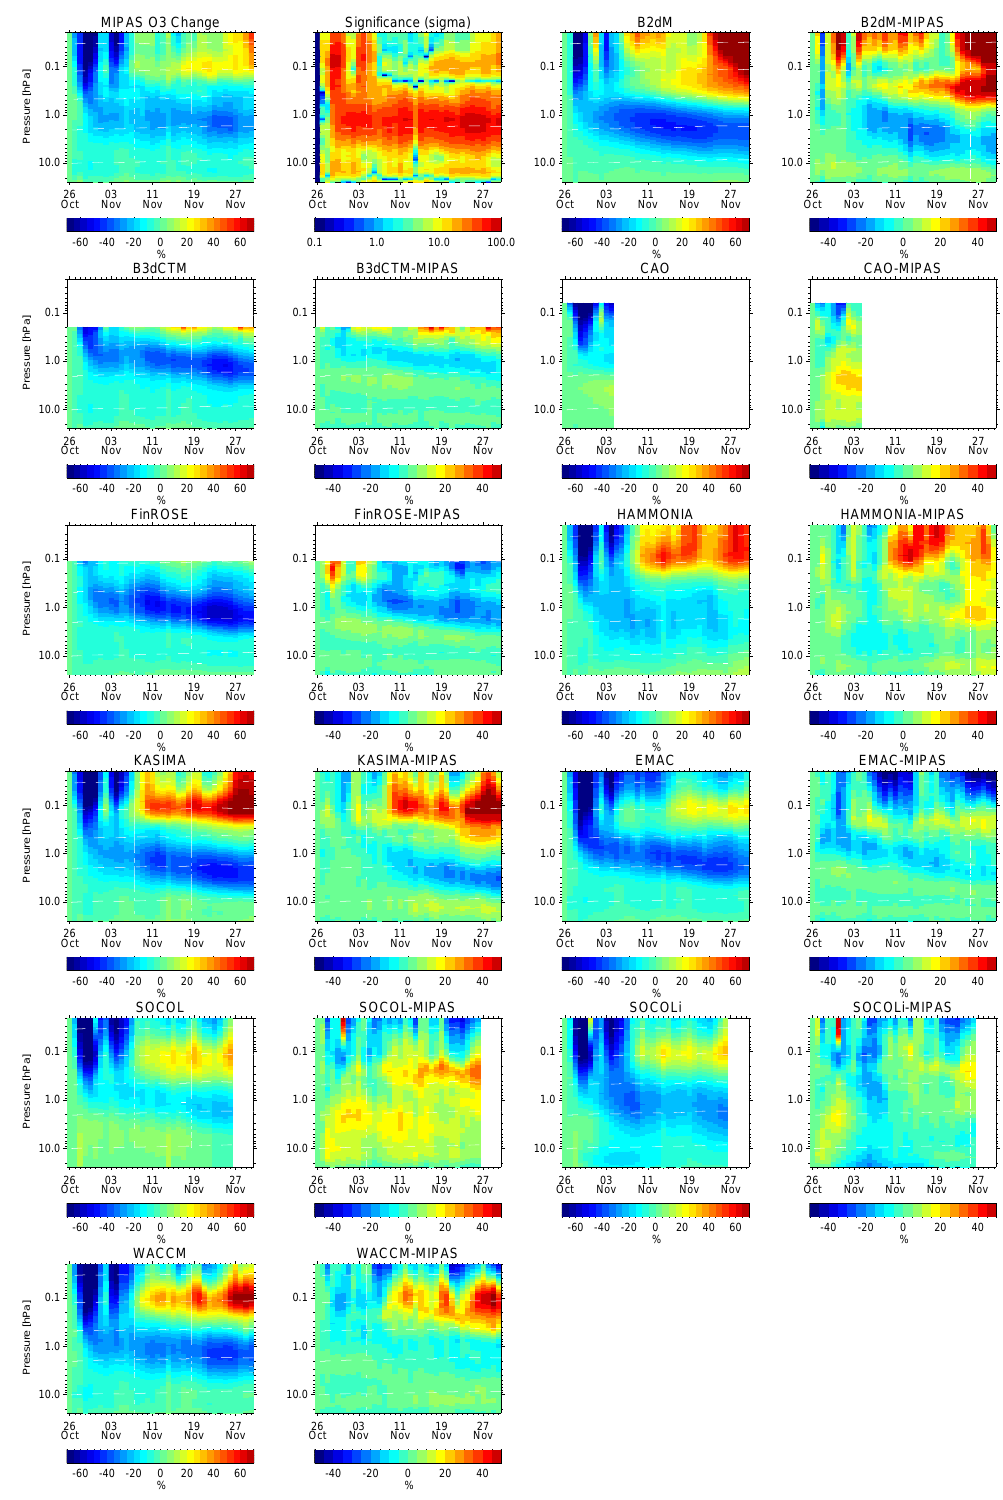
Fig. 26. Temporal evolution of area-weighted averages of relative O 3 changes with respect to 26 October 2003 in MIPAS observations and model simulations at 70–90 ◦ N, as well as differences between modeled and observed averages. The significance of observed O 3 changes (in units of σ ) is shown in the upper second panel (from the left).